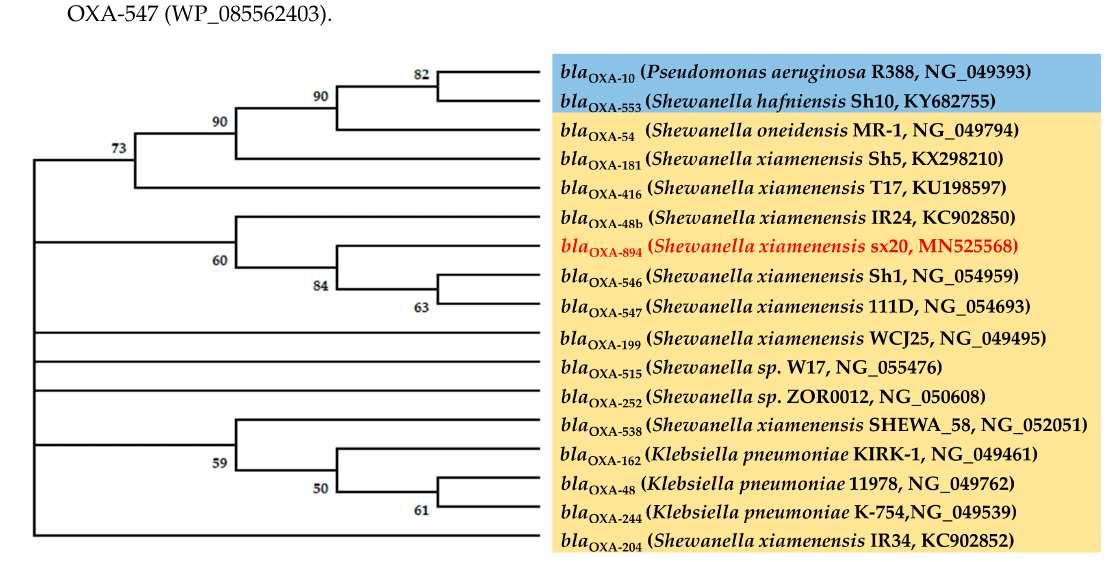
Figure 2. Molecular phylogenetic analysis using maximum likelihood method with 1000 bootstraps of bla OXA ‐ 894 with closest matches and representative nucleotide sequences retrieved from the GenBank database. The phylogenetic tree was constructed using MEGA X software. Bootstrap confidence is shown in %. The bla OXA ‐ 48 ‐ like genes are shown in yellow boxes, and other genes are highlighted in blue boxes.